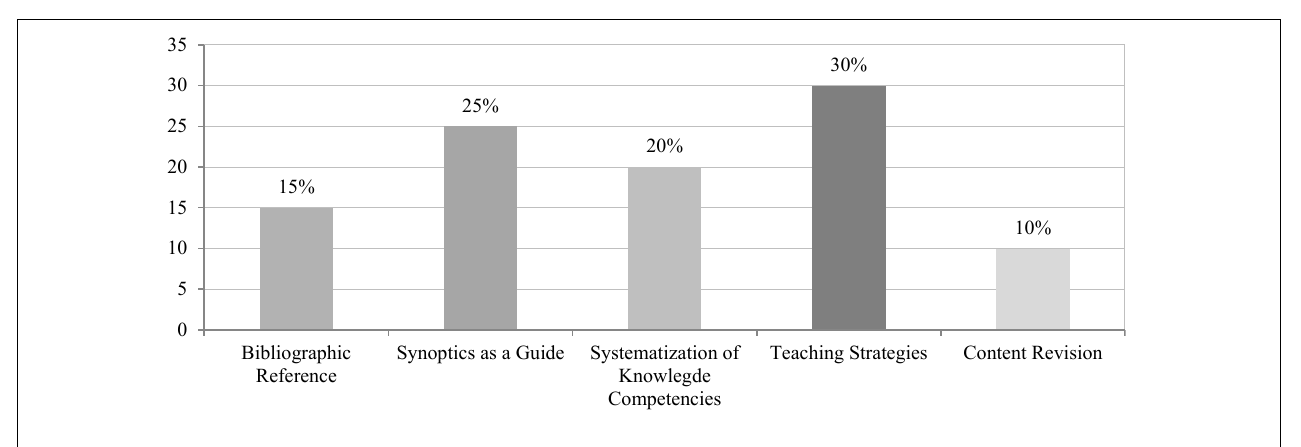
FIGURE 5 | Procedures for generating program